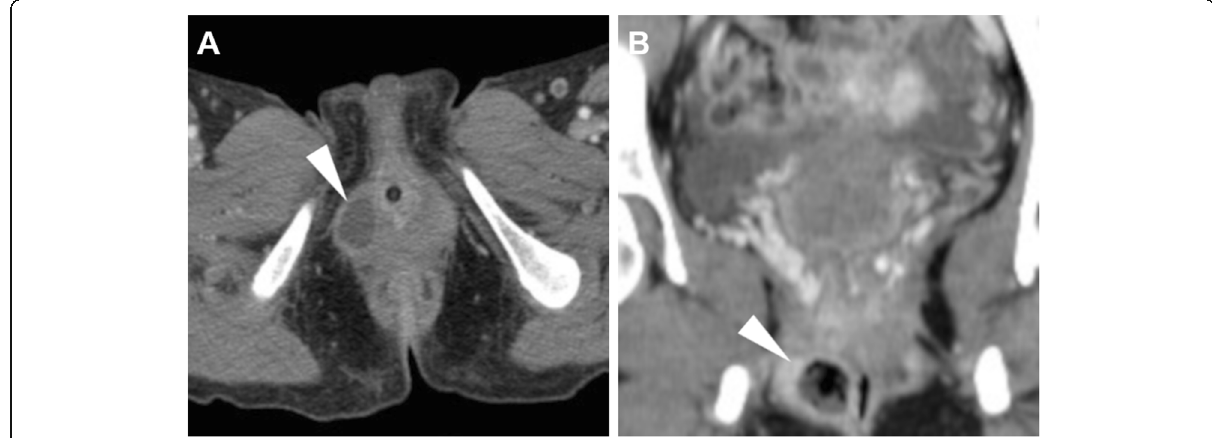
Fig. 23 Two cases of vulvar abscesses (arrowheads) which required surgical incision. a Axial CT image of a small ovoid fluid collection with peripheral enhancement in the left-sided major labia. b Coronal CT image of an abscess with mixed fluid and gaseous content secondary to Bartholin gland